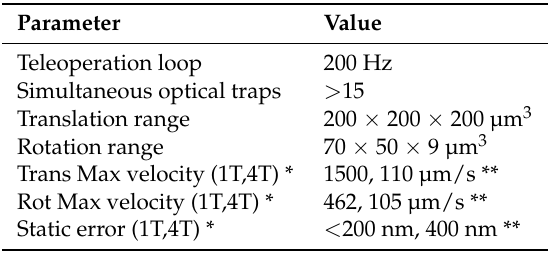
Table 1. Summary of the system